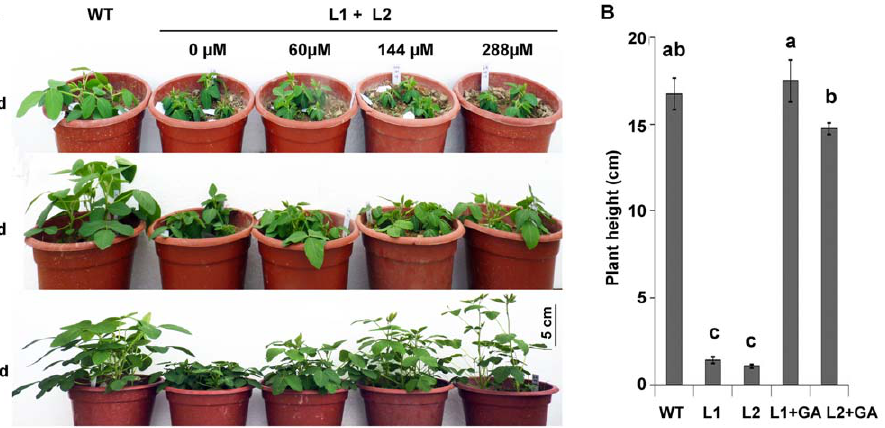
Figure 3. Effects of GA 3 on phenotypic restoration. A: Phenotypes of transgenic plants under 0 m M, 60 m M, 144 m M or 288 m M GA 3 treatments for 7 days and 14 days. B: The plant height of eight weeks of WT and transgenic plants after treated with or without 144 m M GA 3 for two weeks. WT: wide type; L1: AtDREB1A transgenic line 1; L2: AtDREB1A transgenic line 2; L1 + L2: AtDREB1A transgenic plants line1 and 2. Values are the mean of six biological replicates 6 SE, the same letter on each column set indicates no significant difference and different letters are significantly different by the analysis of variance (ANOVA), p , 0.05.